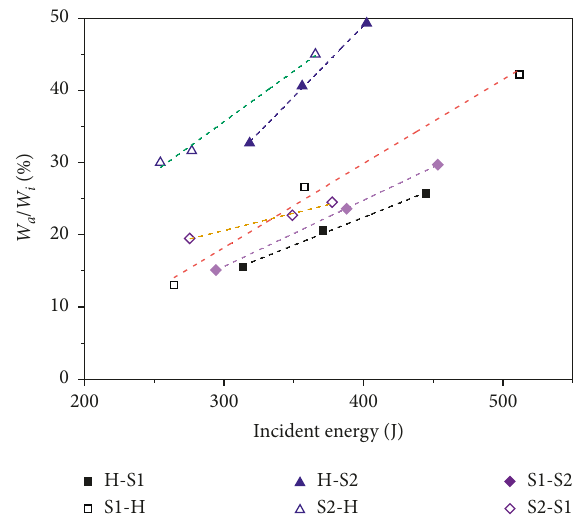
Figure 9: Variations of energy absorption rate versus incident